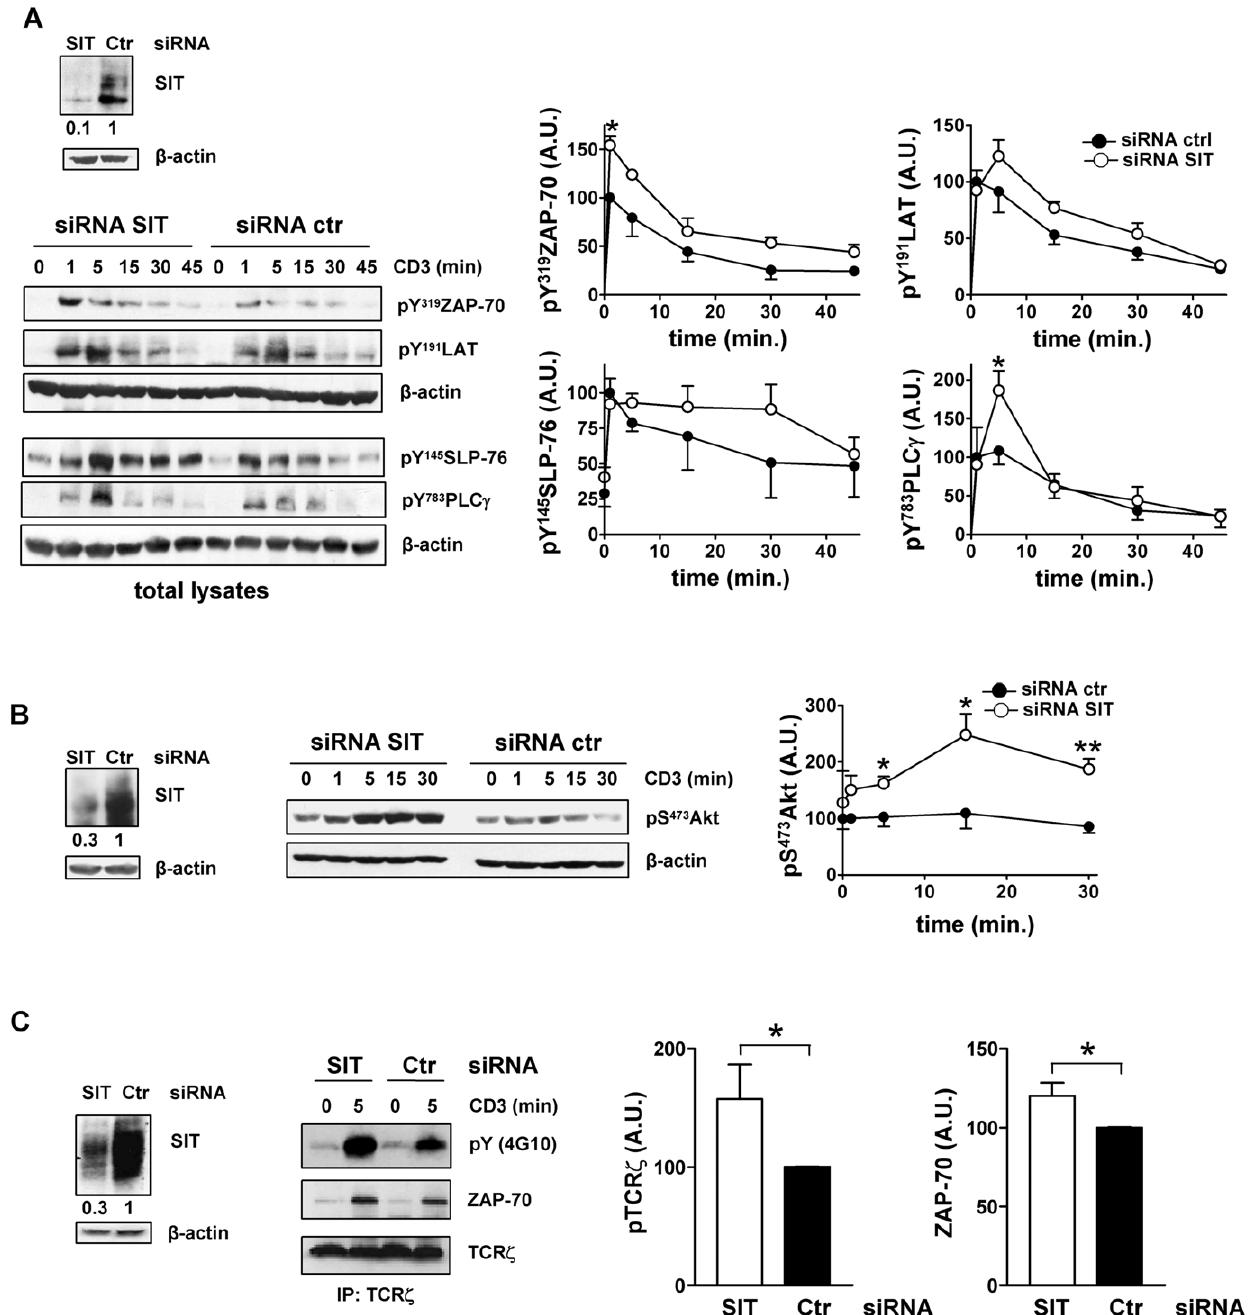
Figure 3. Suppression of SIT expression results in an enhanced proximal TCR signaling. siRNA duplex for SIT or control were introduced in Jurkat T cells by electroporation. Cells were stimulated 48 h after transfection with non-cross-linked CD3 Ab for the indicated times. Total cell lysates (A–B) or TCR f immunoprecipitates (C) were prepared and analyzed by Western blotting using the indicated Abs. The data are representative of at least 3 independent experiments. Immunoblots verifying SIT downregulation are shown. Equal loading is shown by reprobing immunoblots with antibodies specific for b -actin (A–B) or TCR f (C). The phosphorylated bands were quantified using ImageQuant software and values were normalized to the corresponding b -actin signal. Graphs show the phosphorylation levels shown as of arbitrary units 6 SEM of at least 3 independent experiments. Statistical significance * p , 0.05 and **p , 0.01.